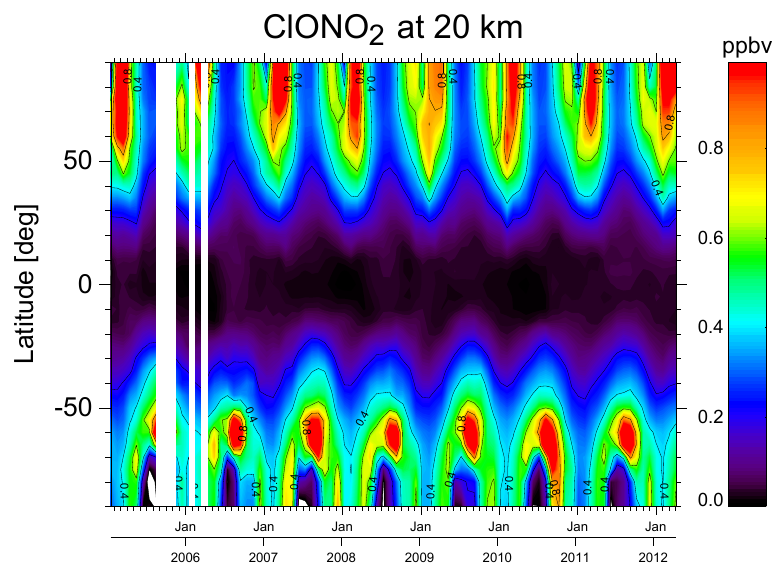
Figure 3. The temporal development of ClONO 2 at 20km, based on MIPAS monthly mean mixing ratios. White stripes represent data gaps due to missing measurements. Figure from von Clarmann et al. (2009), used under CC Attribution 3.0 license.